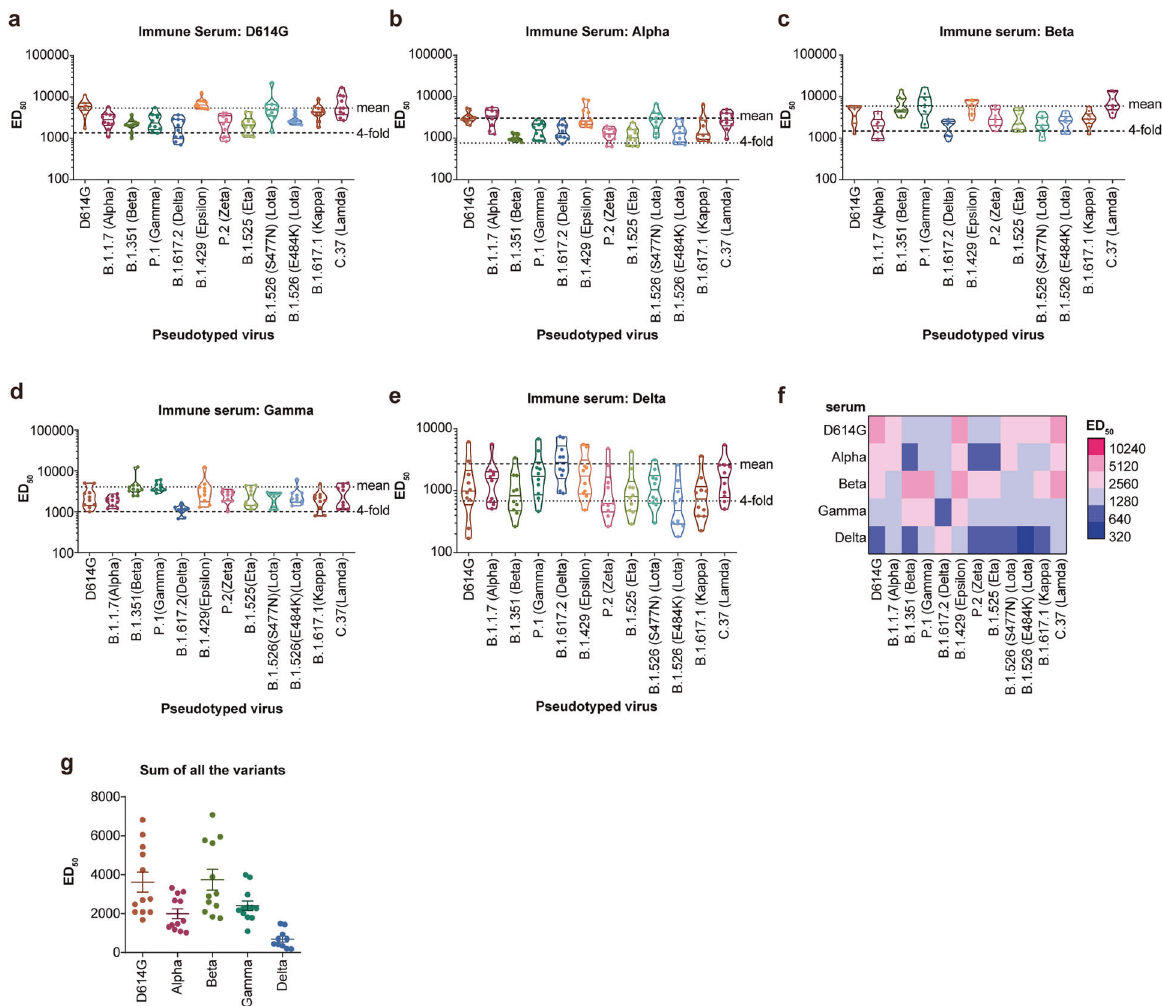
Fig. 2 Neutralization activity of Alpha, Beta, and Gamma S protein-immunized sera against VOCs and VOIs. The SARS-CoV-2 S protein from D614G, Alpha, Beta, or Gamma variants were used to immunize mice. The sera were collected for neutralization activity testing against the indicated VOCs and VOIs. The mean results of neutralization ED 50 from three repeated experiments are shown as a dot plot. a – d The red arrow indicates neutralization against homologous pseudotyped virus. The dashed lines represent the geometric mean and fourfold reduction for serum response of the homologous virus, respectively. e ED 50 heat map of homologous and heterologous sera and virus. f ED 50 of one serum against homologous and heterologous variants are summarized into one column. S spike, VOC variant of concern, VOI variant